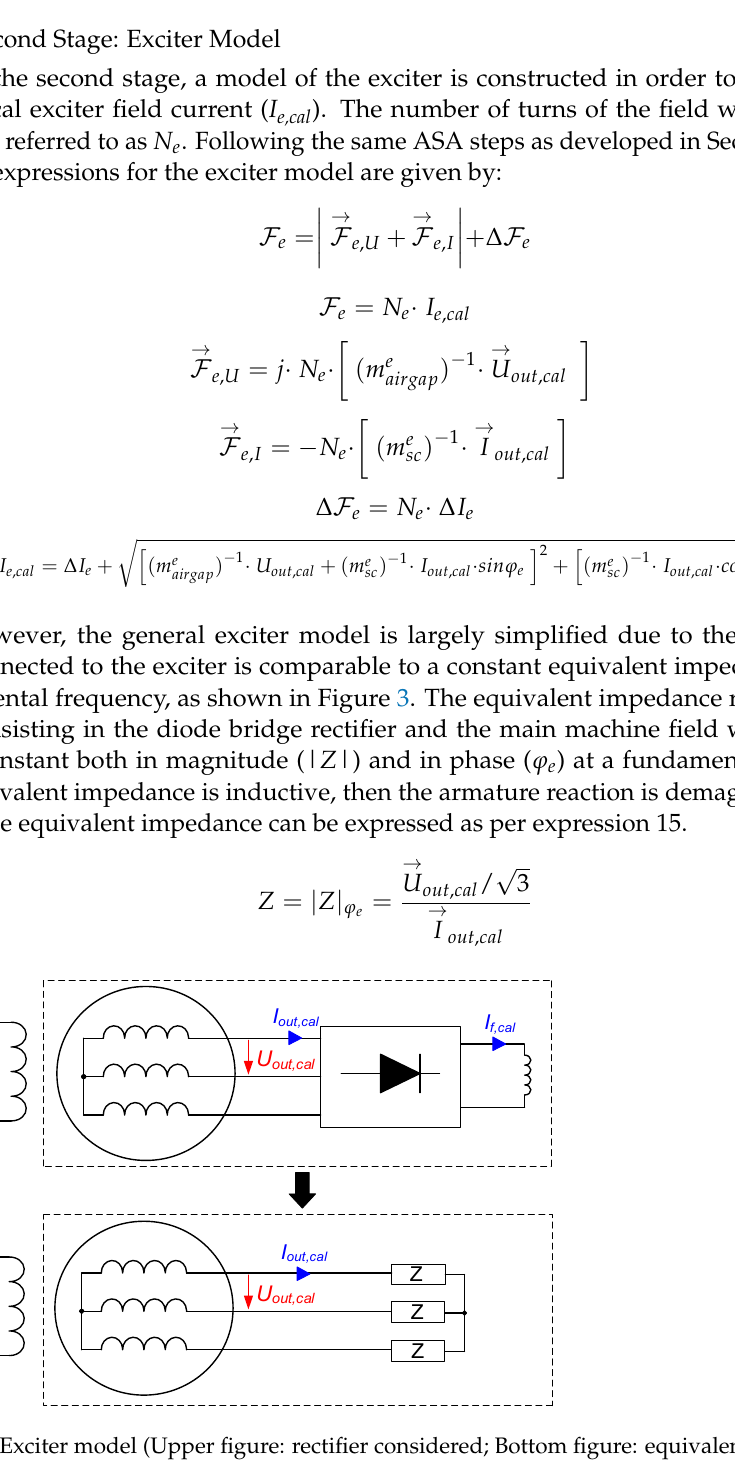
φ e φ e Figure 4. Exciter machine field current calculation by the ASA method. Phasor diagram.